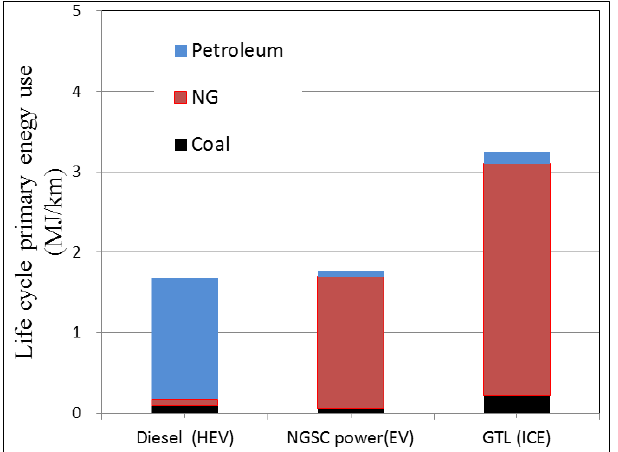
Figure 4. Comparing life cycle fossil energy use of three key fuel pathways (HEV in high energy efficiency case while others in low energy efficiency